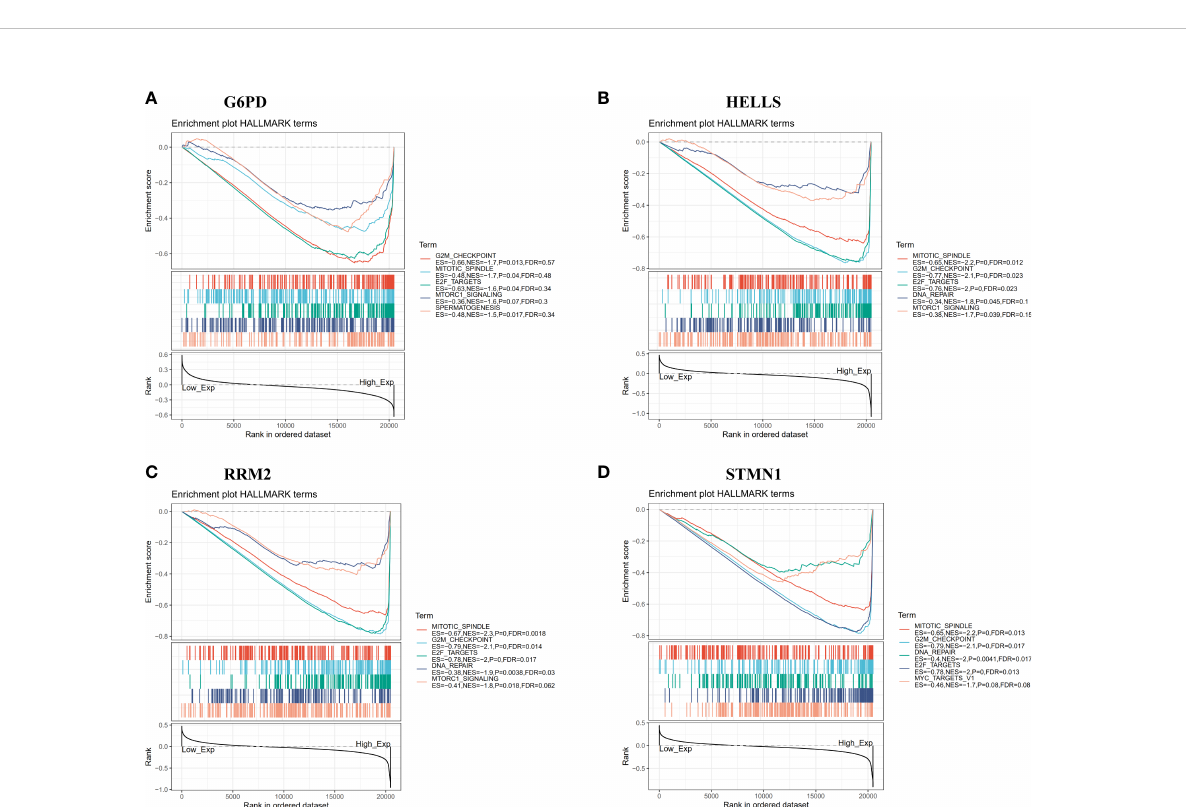
FIGURE 8 Gene set enrichment analysis (GSEA) of 4 hub FRGs in the TCGA-LIHC dataset. (A – D) Top fi ve gene sets (according to GSEA enrichment score) for G6PD, HELLS, RRM2, and